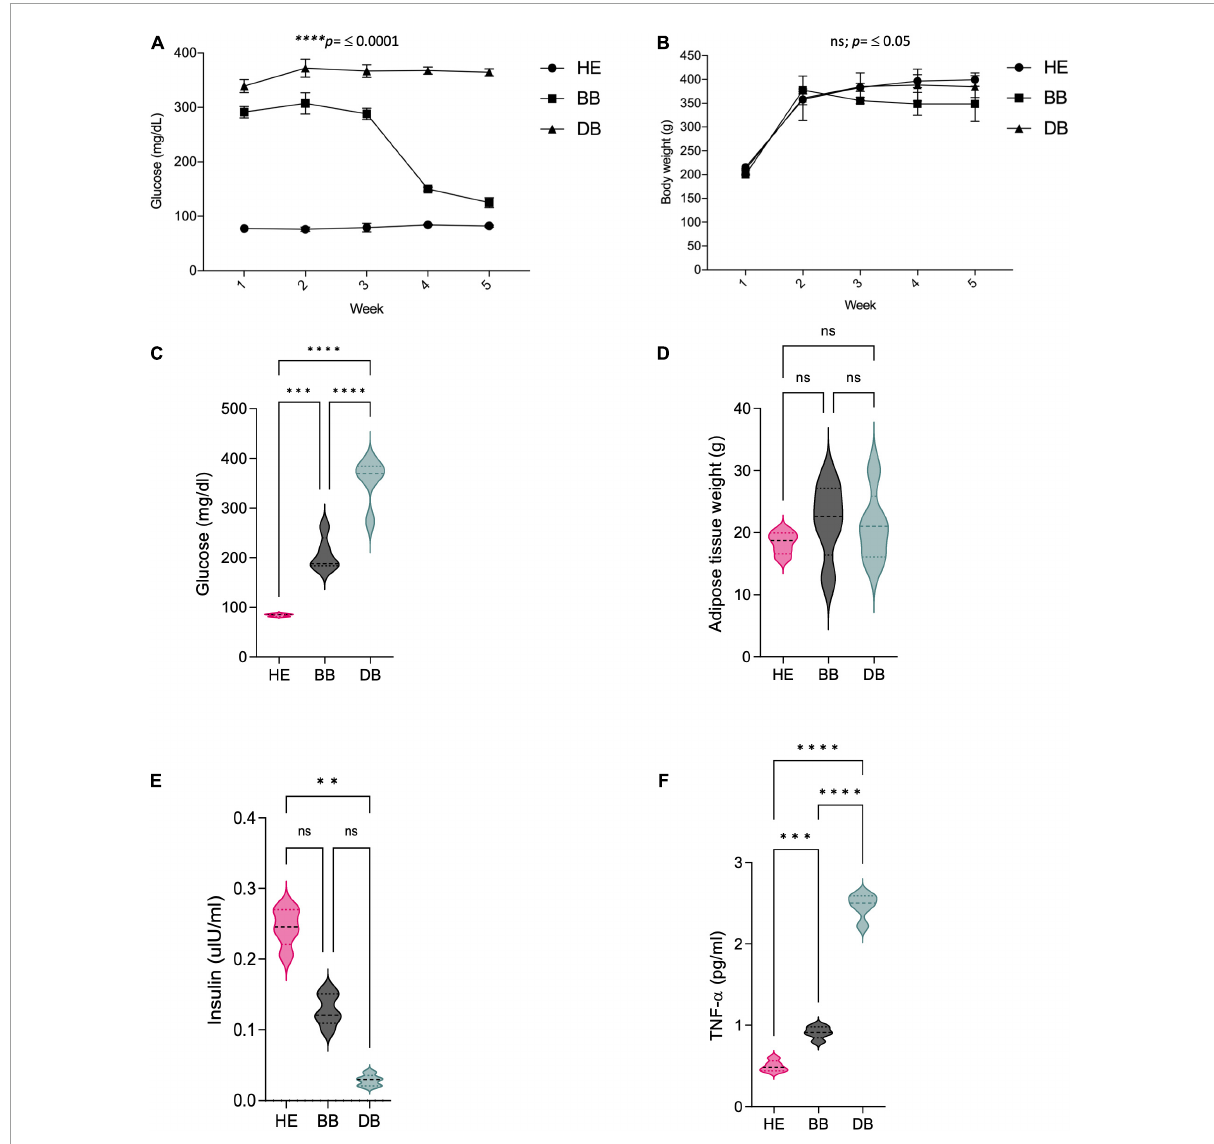
FIGURE1 Effects of 5 weeks consumption of an anthocyanin-rich BB extract on (A) fasting blood glucose; (B) body weight; (C) glucose levels at the end of the treatment; (D) adipose tissue weight; (E) insulin levels; and (F) TNF- α levels. Values represent the mean and S.D. ( n = 8). ∗∗ p ≤ 0.01; ∗∗∗ p ≤ 0.001 and ∗∗∗∗ p ≤ 0.0001 when BB were compared to the corresponded value of